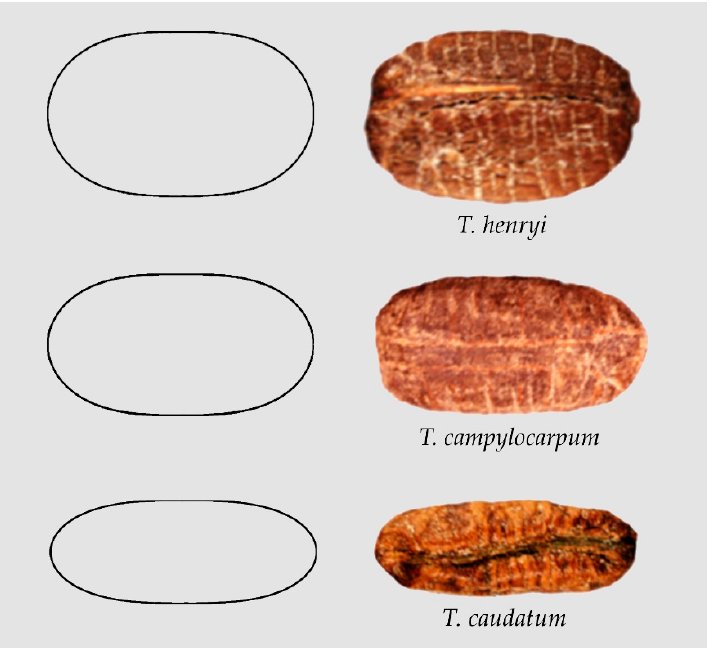
Figure 2. Examples of seed images resembling superellipses with different length/width ratios: First row: Tetrastigma henryi [51]. Second row: Tetrastigma campylocarpum [51]. Third row: T. caudatum [51].